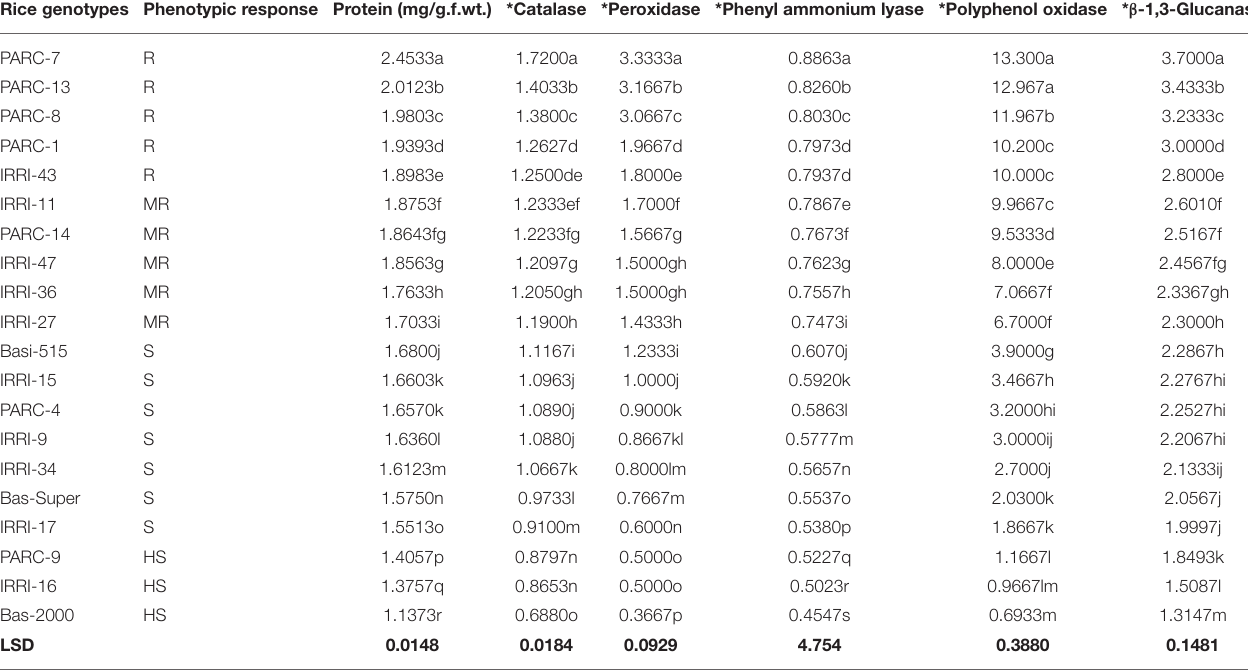
TABLE 3 | Comparative analysis of total Protein and defense enzyme contents in disease resistant and susceptible rice